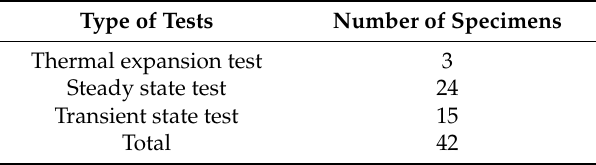
Table 2. Number of specimens in this study.